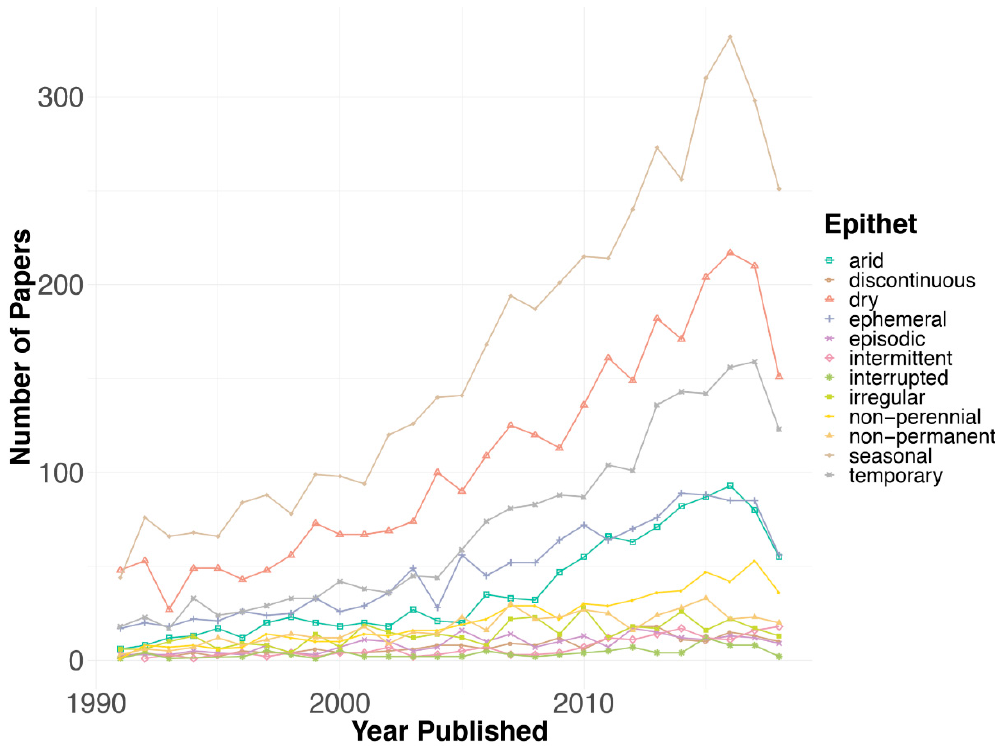
Figure 4. Publications of each epithet over time. Abstracts from 1990 to 2017 were compiled to see how epithet use has changed over time. Each epithet was counted once per abstract. Broader terms such as “seasonal,” “dry,” and “temporary” have been used the most frequently. “Temporary,” “non-perennial,” and “intermittent” are the three terms with the largest rate of increase over time.